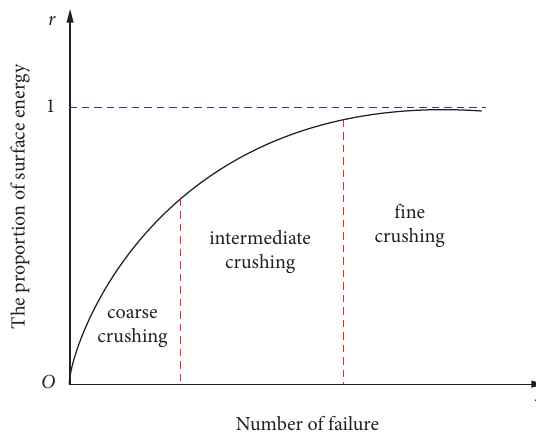
Figure 3: Changing curve of surface energy percentage.